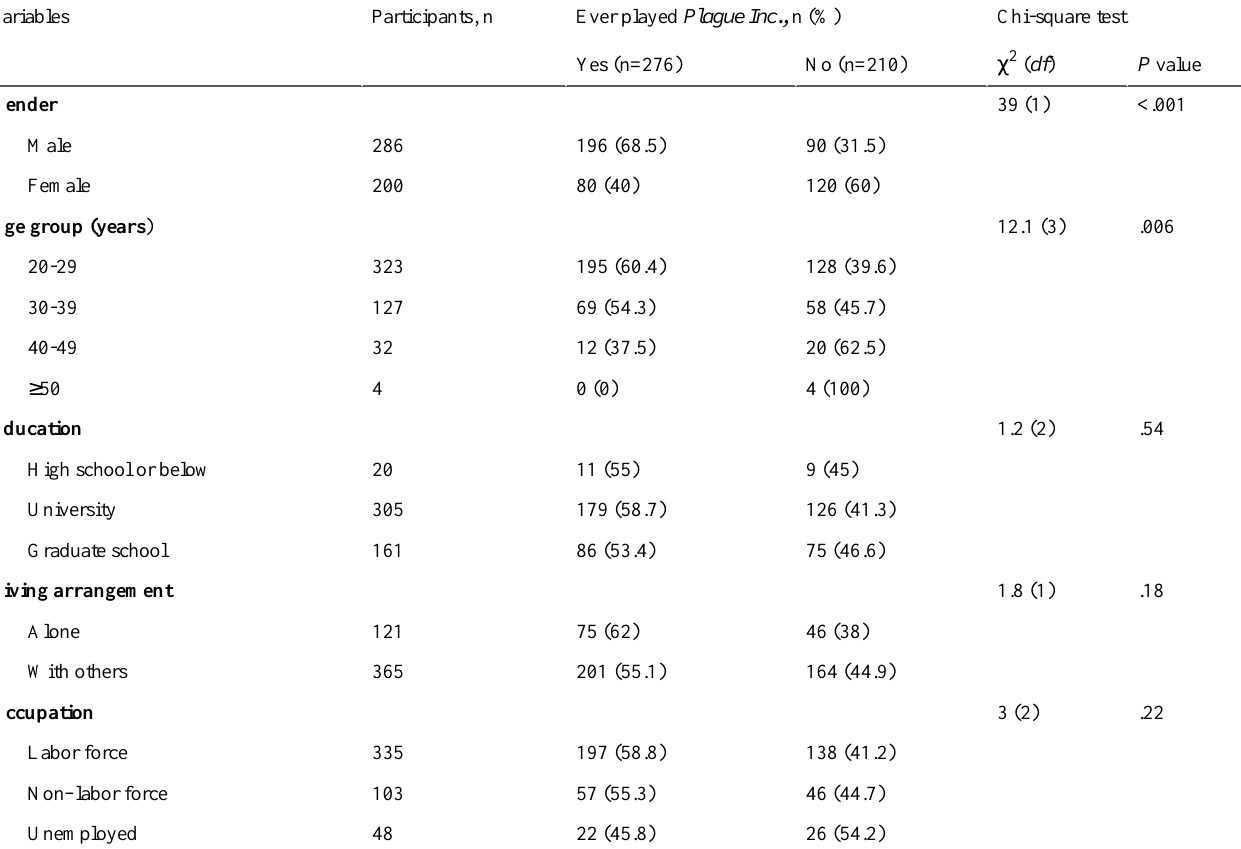
Table 4. Chi-square test for demographic characteristics between those who have or have not played Plague Inc. (N=486).